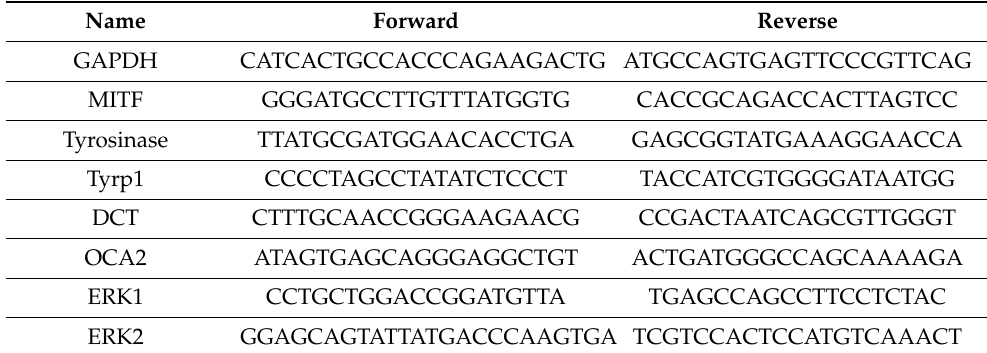
Table 1. List of primers used for quantitative real-time